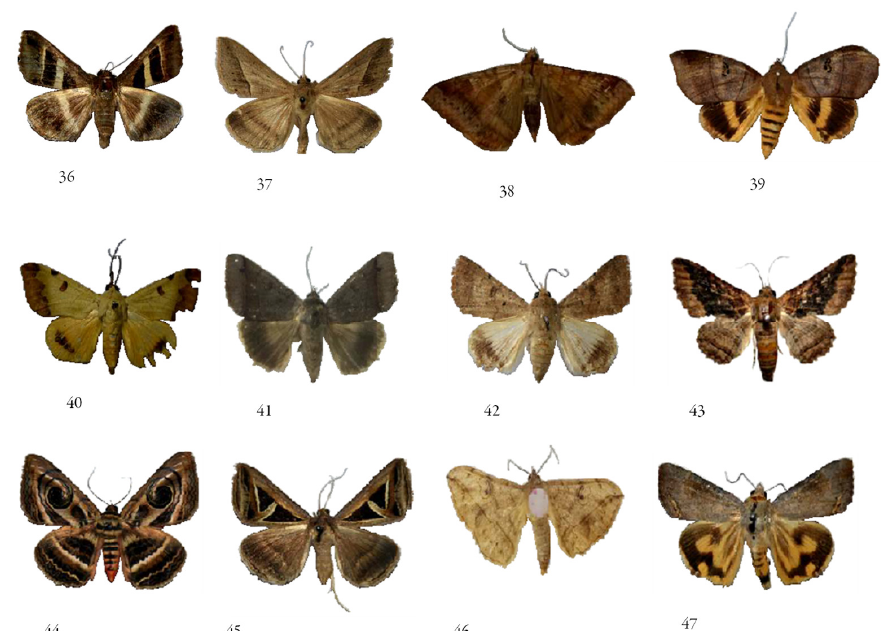
Plate 4. 36- Grammodes geometrica; 37- Mocis frugalis; 38- M. undata; 39- Thyas coronata; 40- Ophiusa tirhaca; 41- O. triphaenoides ; 42- Pandesma anysa ; 43- Pericyma cruegeri; 44- Spirama retorta ; 45- Trigonodes hyppasia; 46- Anticarsia irrorata; 47- Hypocala deflorata